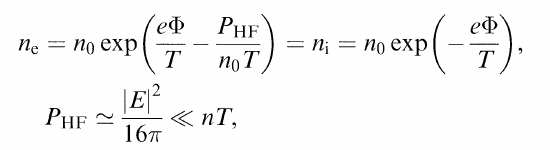
FIGURE 2 Langmuir